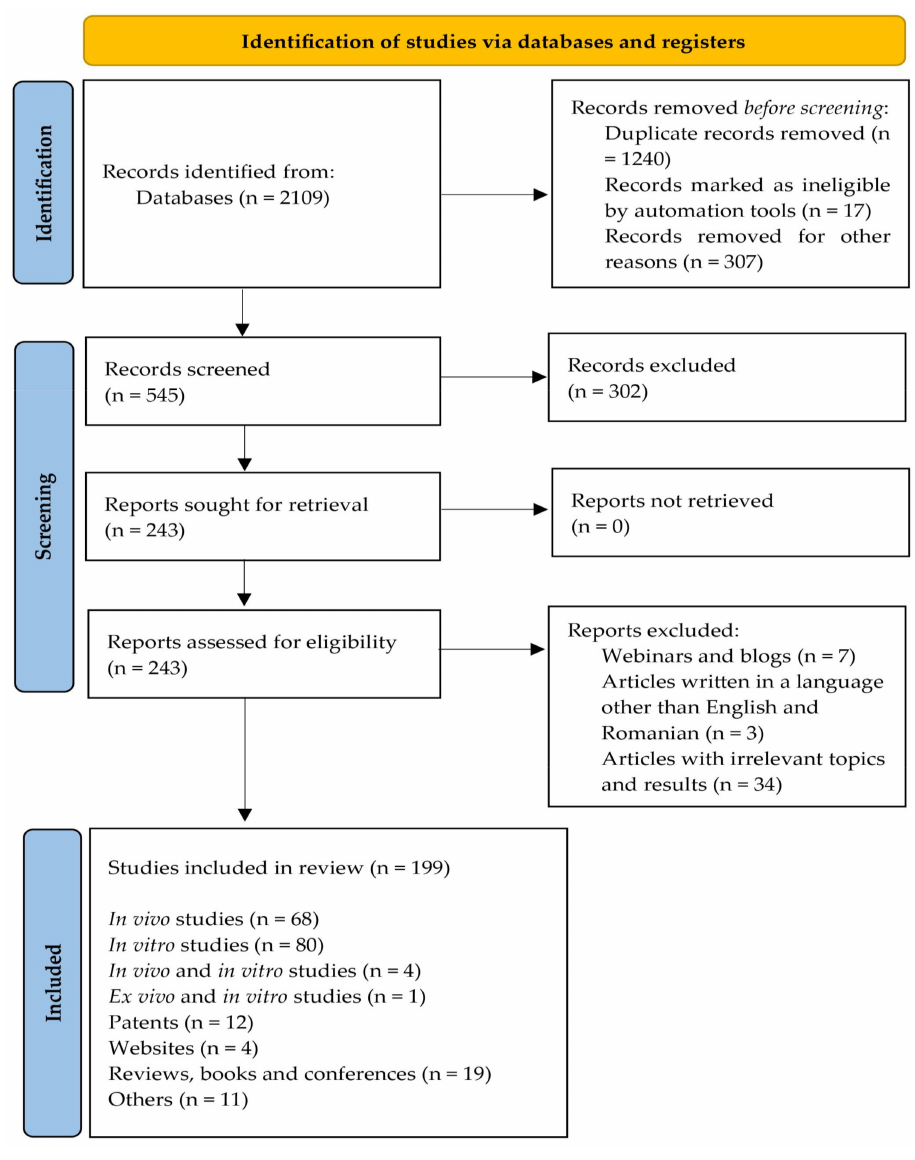
Figure 1. PRISMA 2020 flow diagram for the present